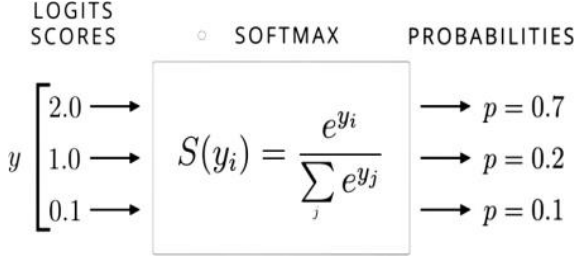
Figure 2. Softmax Activation function overview.